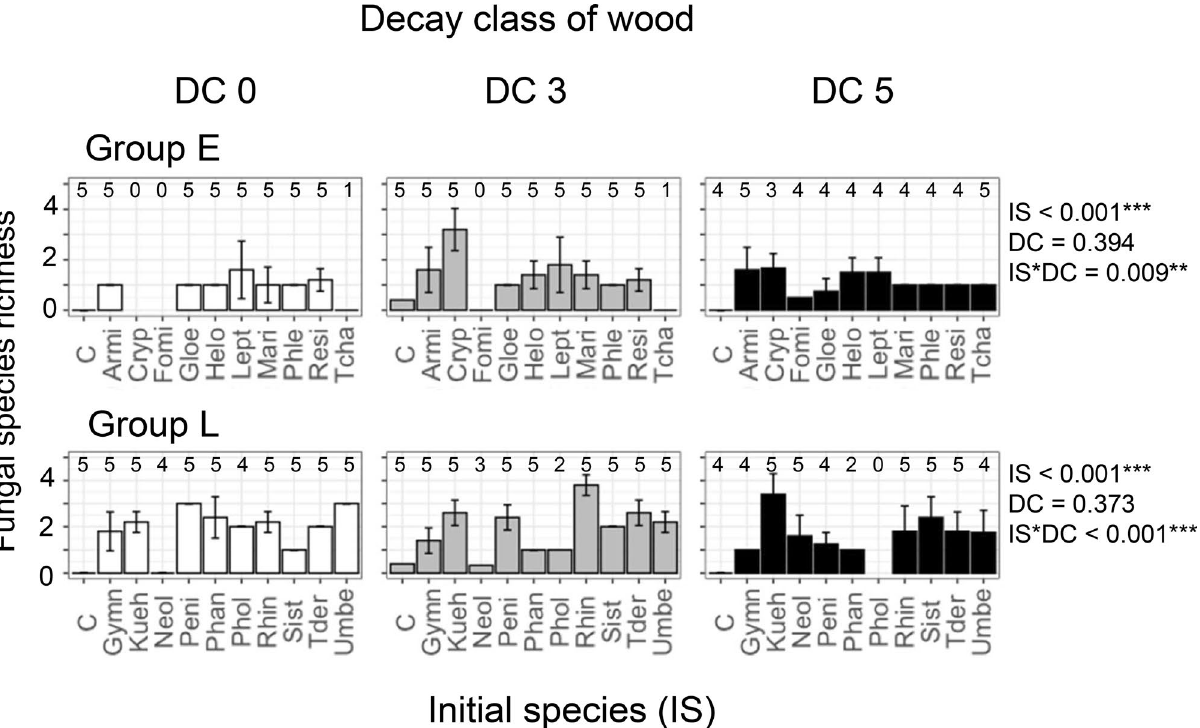
Figure 2. Effect of fungal colonization history on fungal species richness. Species richness (mean ± SD) was measured 5 months after all species were introduced. P values from ANOVAs are provided for effects of initial species (IS), decay class (DC), and their interactive effects (IS*DC). Asterisks indicate ** P < 0.01 and *** P < 0.001. Codes for initial species are provided in Table 1. C, control (sterile agar plugs were introduced instead of fungi plugs). Numbers on the bars indicate replicate number of the sample. Color of the bars indicate DC of wood substrates: white, DC 0; grey, DC 3; black, DC